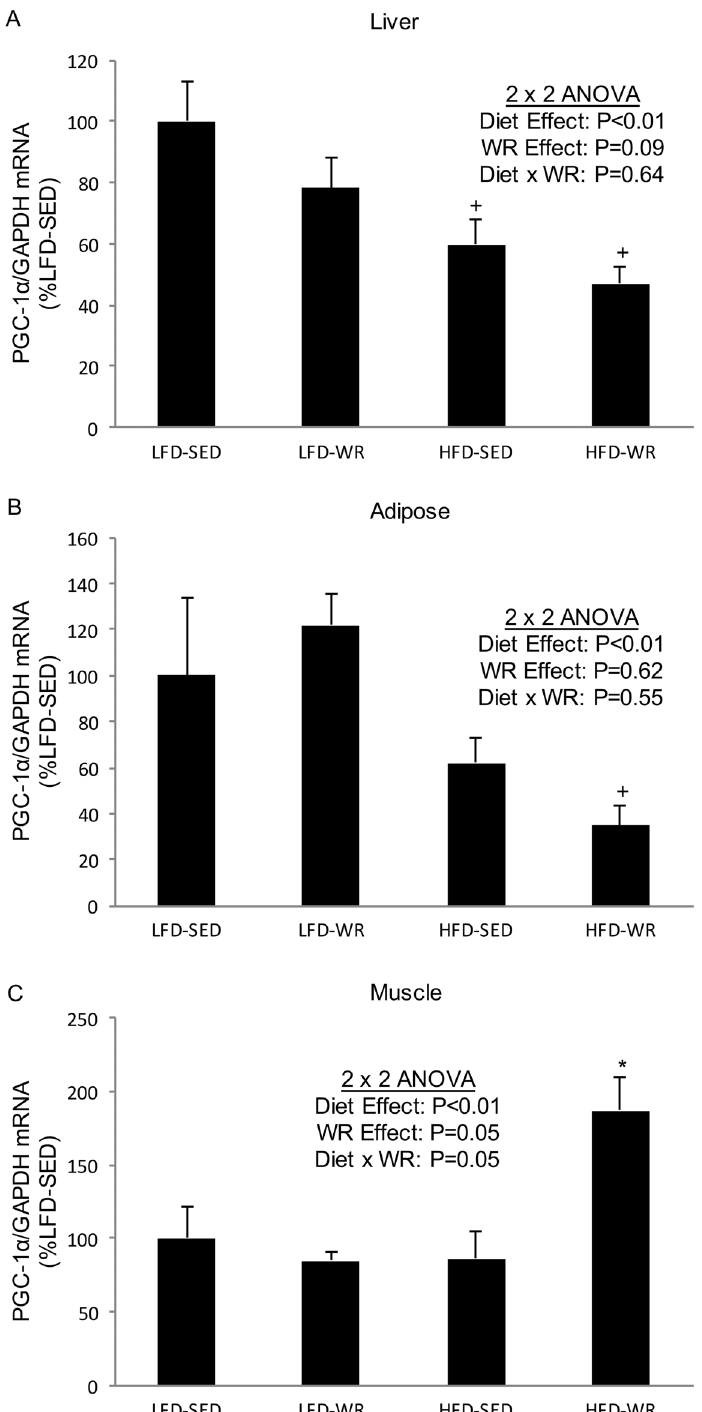
Fig 5. The effects of a high fat diet and voluntary wheel running on PGC-1 α mRNA expression in liver, adipose tissue, skeletal muscle. PGC-1 α gene expression for liver (Panel A), epididymal adipose tissue (Panel B), and soleus muscle (Panel C) were normalized to GAPDH and expressed relative to LFD-SED values. * Denotes statistically significant difference from all other groups by Fisher ’ s LSD post-hoc test. + Denotes statistically significant difference from respective LFD groups by Fisher ’ s LSD post-hoc test. The number of mice per group is 4 –